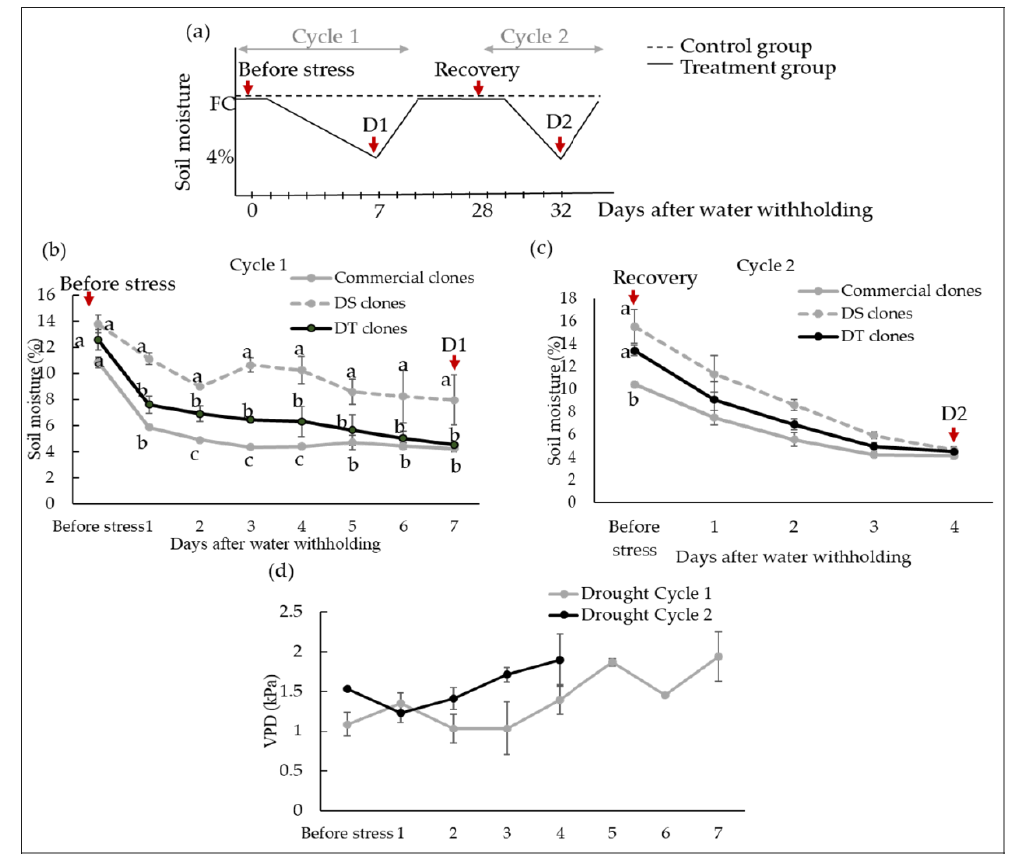
Figure 2. ( a ) Schematic representation of the experimental design: variation in soil moisture in both control (dotted lines) and treatment groups (solid lines) during two cycles of dehydration and rehydration. Arrows indicate four different time points where measurements were taken (before stress, the peak of the 1st drought cycle (D1), after full recovery, and the peak of the 2nd drought cycle (D2)). ( b ) Depletion of soil moisture in drougt-treated commercial, DS and DT clones during 1st and ( c ) 2nd dehydration cycles, and ( d ) changes in vapour pressure deficit (VPD) during 1st (grey line) and 2nd (black line) drought events. Values are means ± SEM of six to nine biological replicates. Statistical analysis was conducted using two-way ANOVA and lowercase letters denote statistically significant differences ( p < 0.05) between clones at each time point.